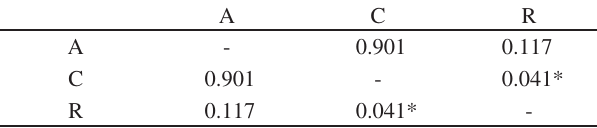
Table 3. Tukey HSD post hoc test of fracture torque values. P-value A C R